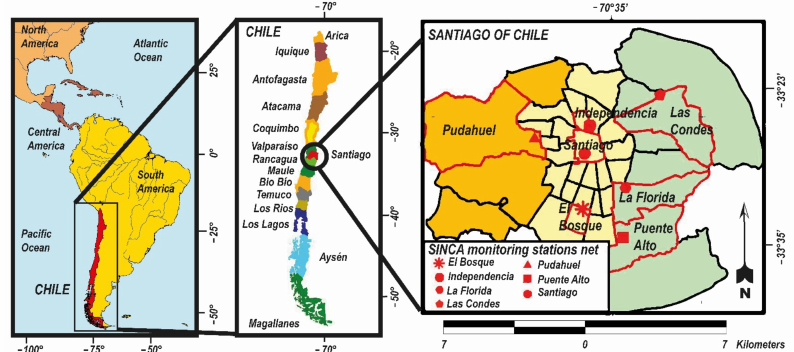
Figure 2. Metropolitan area of Santiago communal map with their monitoring